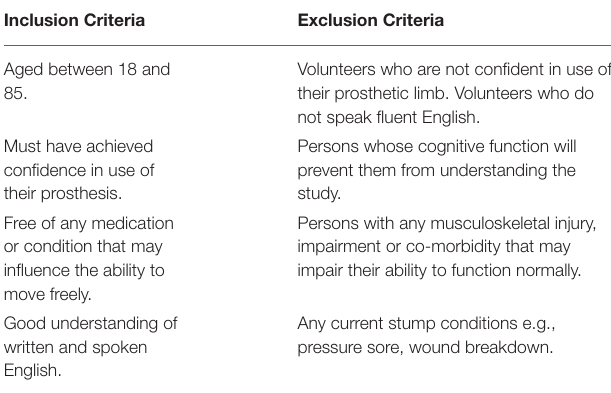
TABLE 2 | Inclusion and exclusion criteria for participation in the